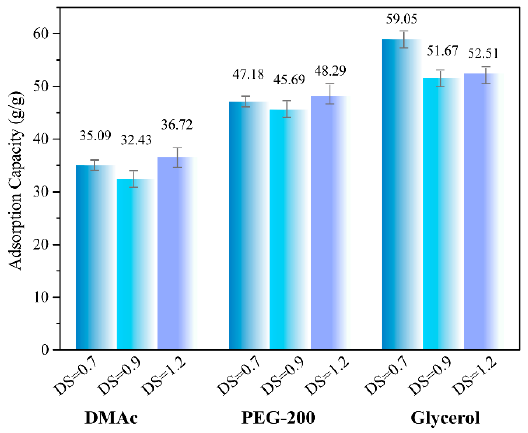
Figure 6. Adsorption capacity of CMC aerogels with DS = 0.7, 0.9 and 1.2.